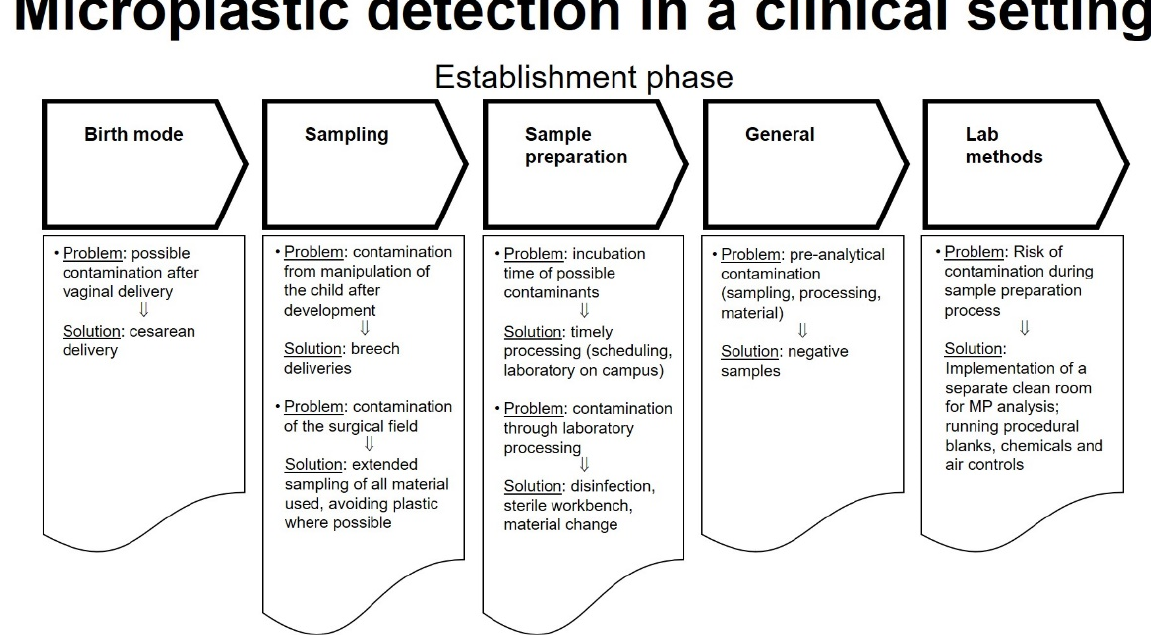
Figure 1. Microplastic detection in a clinical setting, “Establishment